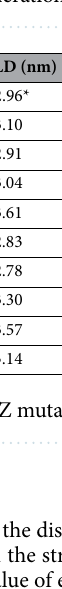
Figure 2. Normalized absorption spectra of ( a ) wtPZ and hinge mutants and ( b ) β -sheet mutants. Dark regeneration time courses measured at λ max for ( c ) wtPZ and hinge mutants and ( d ) β -sheet mutants. ( e ) λ max and τ 1/2 values of dark regeneration. *Data for wtPZ were taken from a previous study 16 .